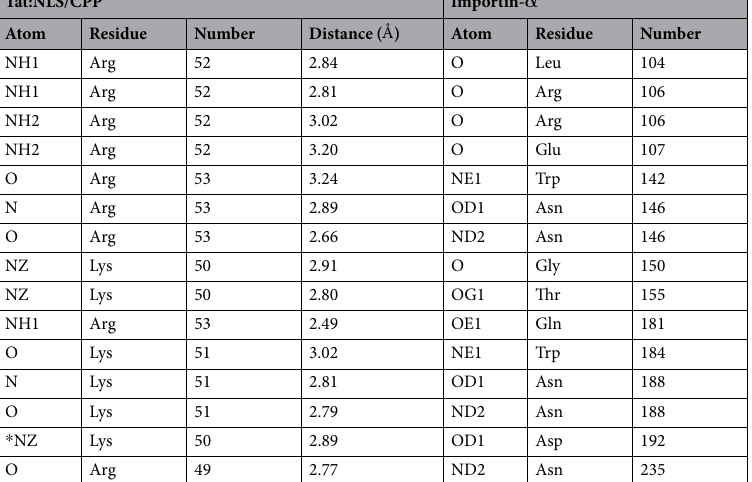
Table 2. Tat:NLS/CPP hydrogen bond interactions with importin- α generated by PDBSum 35–38 * Salt bridge